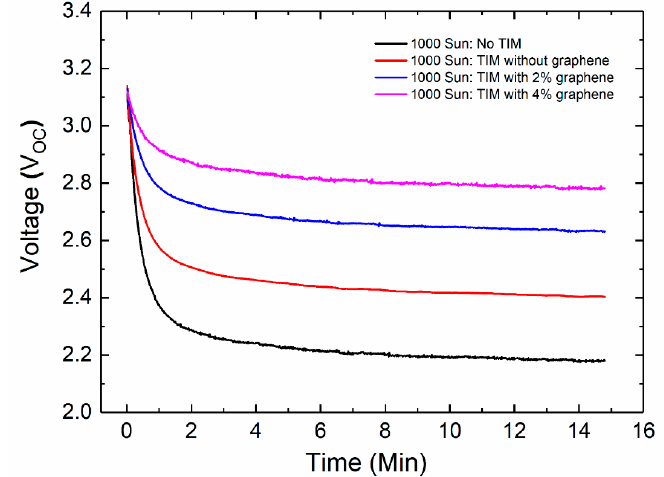
Figure 8. Open-circuit voltage of the solar cell under concentrated illumination corresponding to 1000 suns. The results are shown for the cell without thermal interface material, for the same cell with commercial thermal interface materials, and for the same cell with graphene-enhanced thermal interface materials. Note that the use of 4% graphene fillers added to commercial thermal paste allows for substantial increase in the open-circuit voltage.